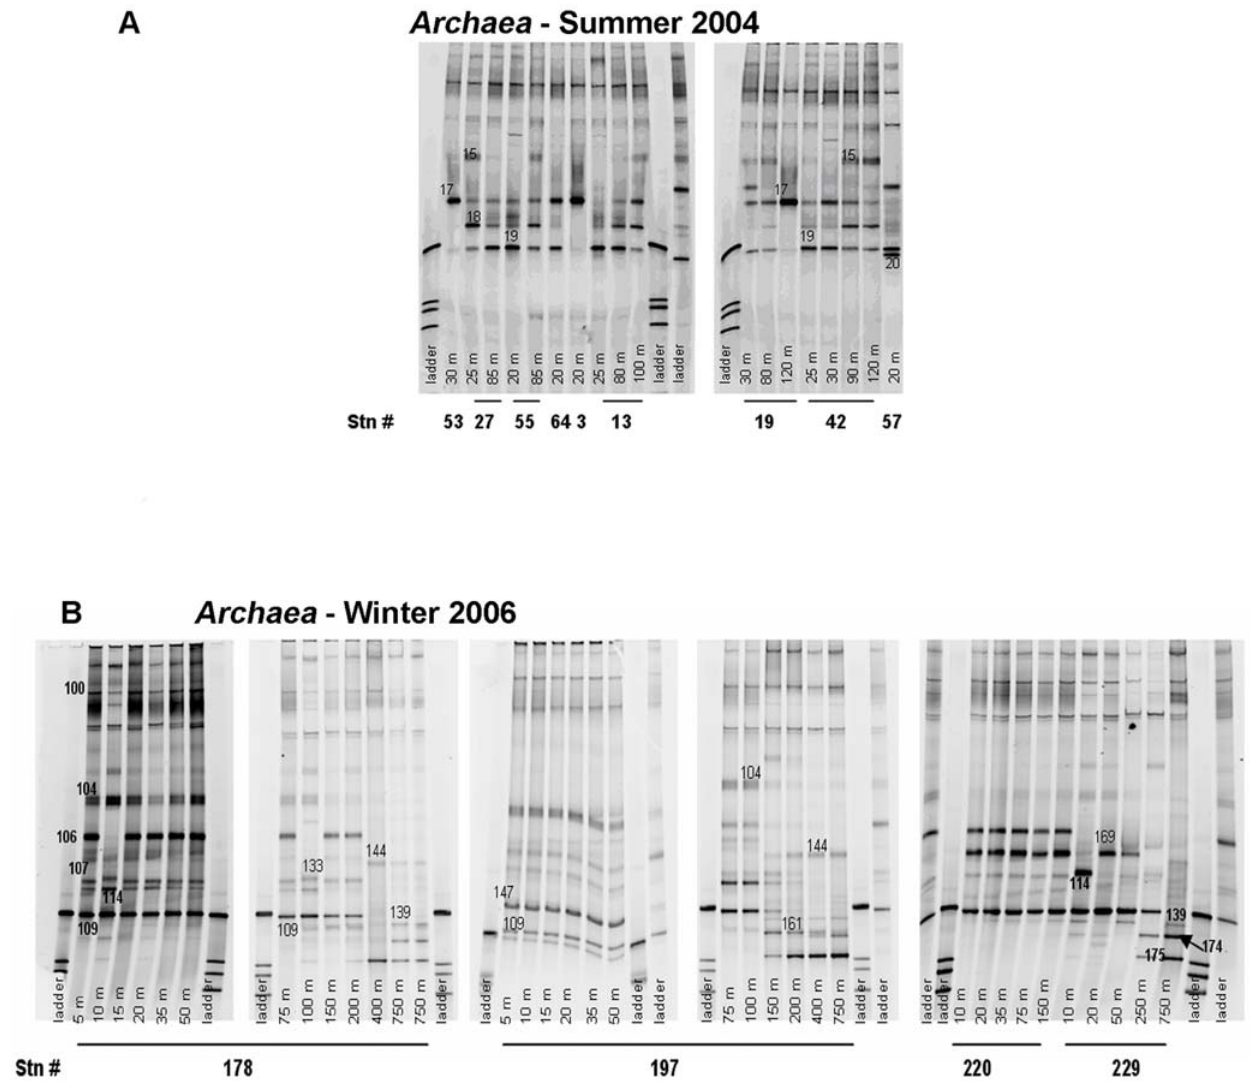
Figure 6. DGGE fingerprint of Archaea amplicons from Summer 2004 (A) and Winter 2006 (B) samples. The numbered bands have been excised for